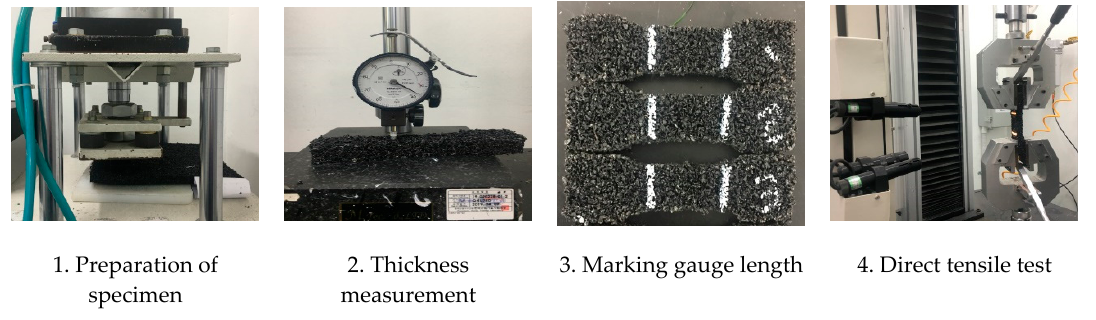
Figure 3. Direct tensile test procedure.